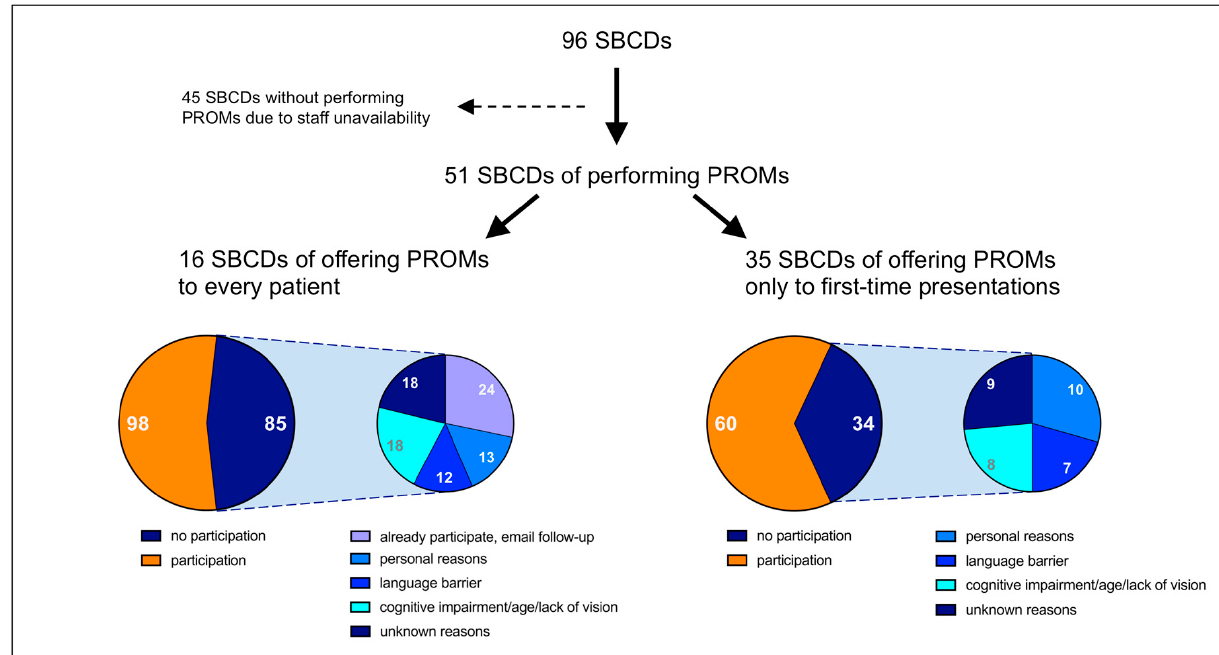
Figure 1. Availability of PROMs within 2 years after implementation, participation rate, and reasons for non-participation. Numbers in white/gray = number of patients (each left circle) who participated (orange) or did not participate (dark blue), or number of patients subdivided according to reasons for non-participation (each right circle).